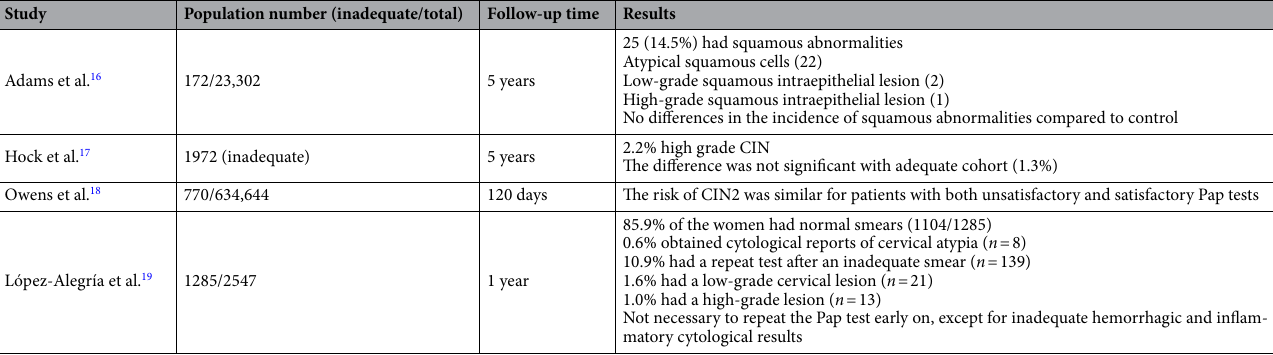
Table 5. Previous studies of follow-up outcomes of an unsatisfactory pap smear. CIN: cervical intraepithelial